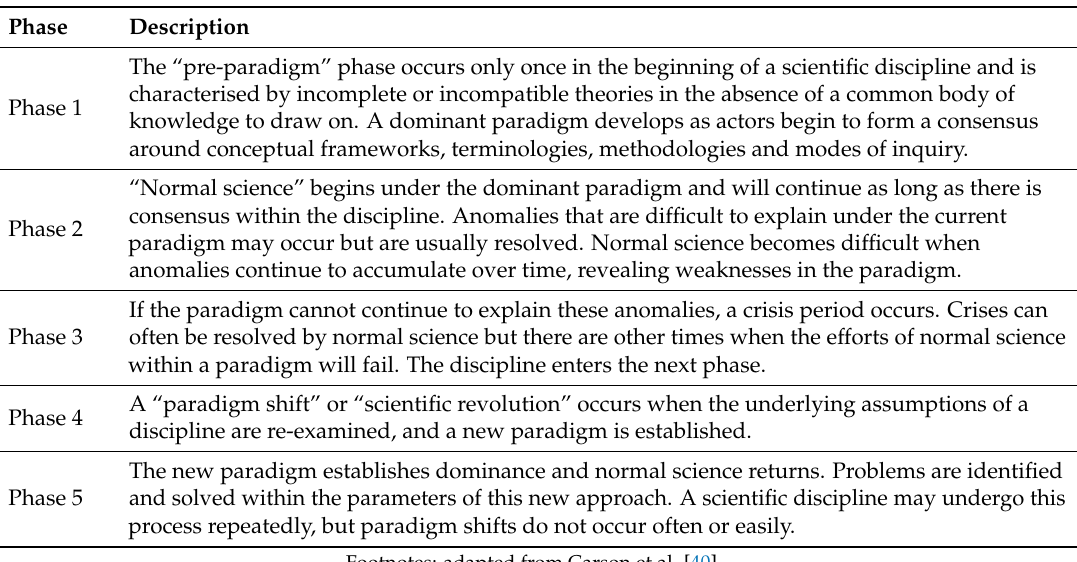
Table 1. Overview of Kuhn’s five phases of a paradigm